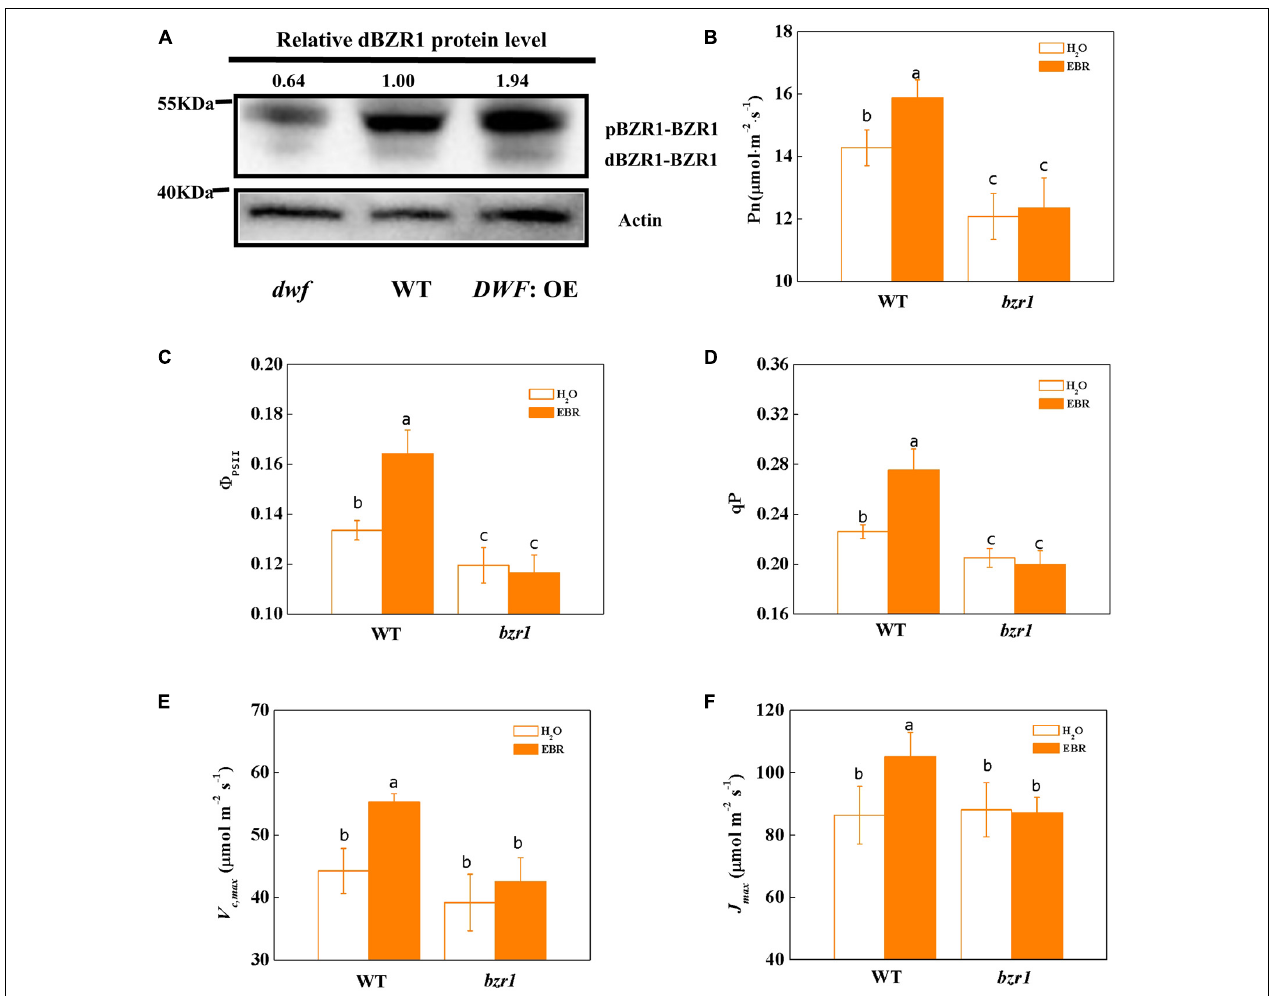
FIGURE 2 | Influence of BZR1 on photosynthesis in tomato plants. (A) Induction of dephosphorylation of BZR1 by endogenous BRs. The phosphorylated and dephosphorylated forms of BZR1 are termed by pBZR1 and dBZR1, respectively. Total proteins were probed using an anti-BZR1 multiclonal antibody. The ratio reflects the relative abundance of dBZR1 to total protein, expressed as a number. Actin was used as the loading control. The signal intensity of dBZR1 protein was analyzed with Image Lab. The dBZR1 level of WT plants was set as one. (B) Net photosynthetic rate (Pn). (C) The actual quantum yield of PSII ( (cid:56) PSII ). (D) Photochemical quenching coefficient (qP). (E) Maximum ribulose-1,5-bisphosphate carboxylase/oxygenase (Rubisco) carboxylation rate ( V c , max ). (F) Maximum ribulose-1,5-bisphosphate (RuBP) regeneration rate ( J max ). Five-week-old bzr1 mutant and wild type (WT; “Condine Red”) plants were used for this analysis. EBR (200 nM) was applied at 8:00 in the morning. For (B–D) , values were measured 24 h after EBR treatment. For (E,F) , values were measured 48 h after EBR treatment. For (B–F) , the data represent the means ± SD of at least three biological replicates. Different letters represent significant differences ( p < 0.05) according to Tukey’s test. Three independent experiments were performed with similar